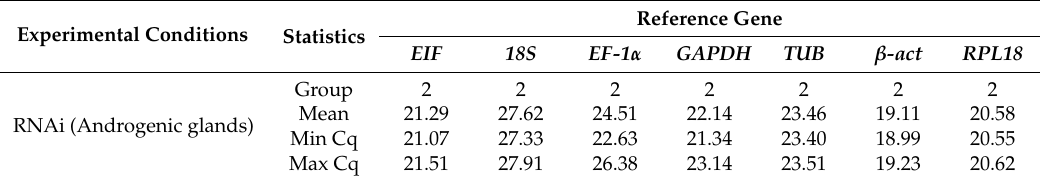
Table 3. Detailed Cq value sorting of RNAi.